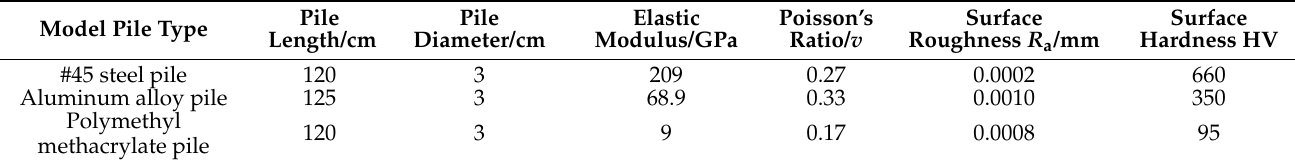
Table 2. The physical parameters of model piles.